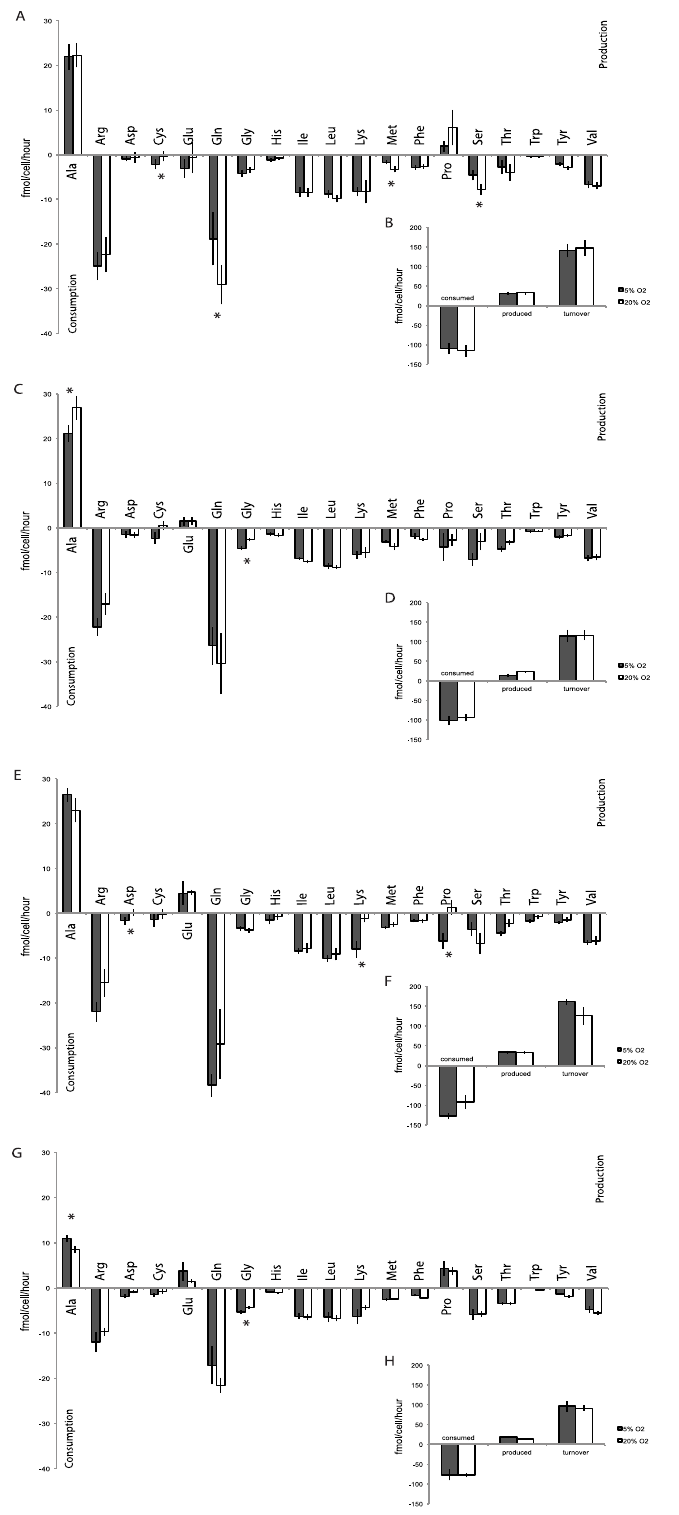
Fig 5. Amino acid utilisation profiles in MEL1 human ES (A, B), PDL (C, D), NHF1.3 (E, F) and IMR90 (G, H) human iPS cells in response to oxygen. Spent media samples were collected after a 24-hour incubation period (day 4–5), normalised to cell number and an internal standard (imidazole) for analysis by 1 H-NMR. Black bars: 5% oxygen;